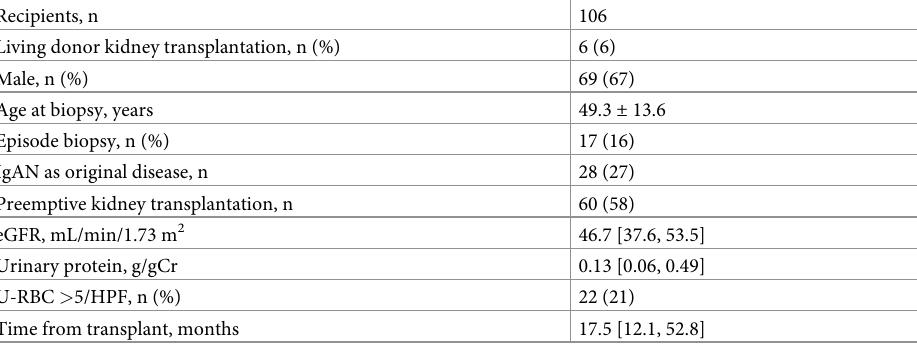
Table 1. Background characteristics of